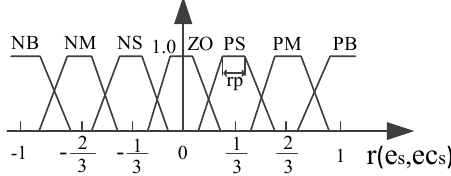
Figure 6. Normalized membership function.